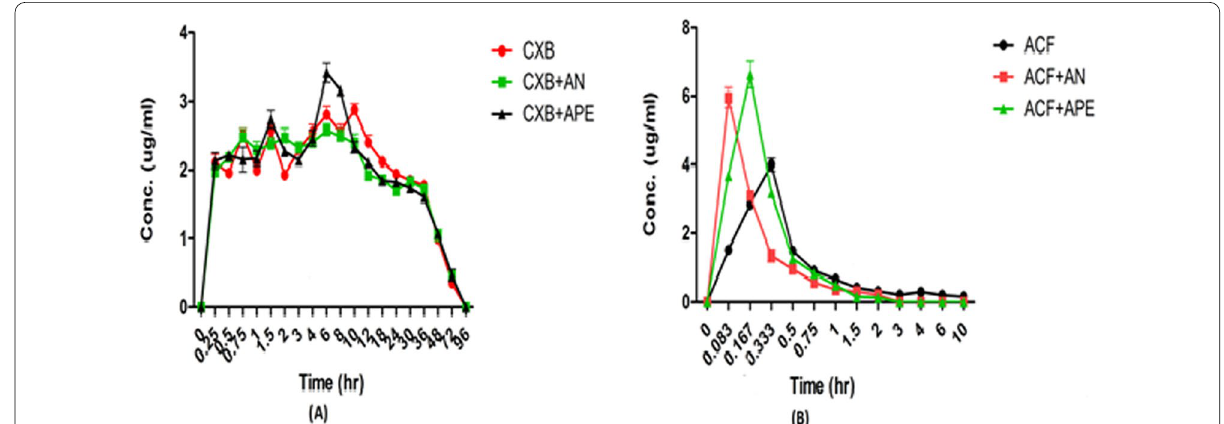
Fig. 3 Mean plasma concentration versus time plot for CXB and